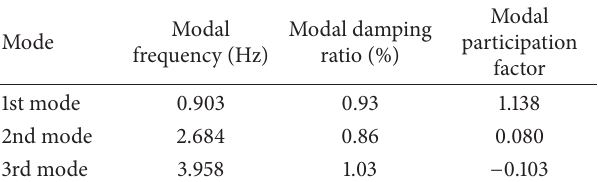
Table 12: Estimation results of dynamic characteristics for Case 2 .